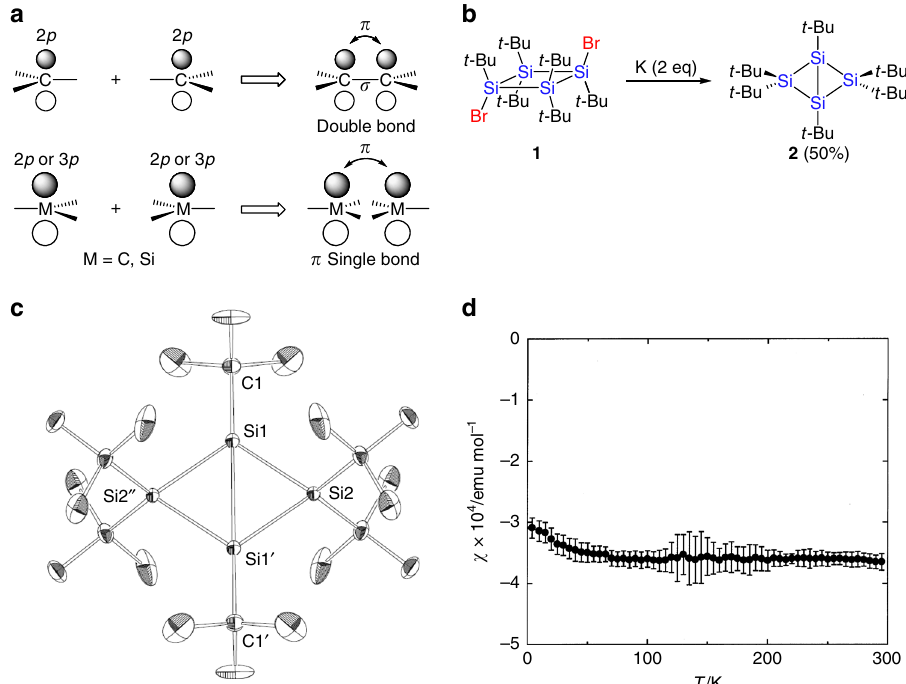
Fig. 1 Synthesis, structure, and magnetic property of 2. a Concepts of a double bond (top) and a π single bond (bottom). b Synthesis of 2 . c Molecular structure of 2 . Thermal ellipsoids are drawn at the 30% probability level. Selected bond length (Å) and angle (°): Si1 – Si2 2.3090(7), Si1 – Si1 ’ 2.853(1), Si1 – C1 1.921(3); Si2 – Si1 – Si1 ’ 51.83(2), Si2 – Si1 – Si2 ” 103.65(4), Si2 – Si1 – C1 128.07(2), Si1 ’– Si1 – C1 176.1(1), Si1 – Si2 – Si1 ’ 76.35(4). d Temperature-dependent magnetic susceptibility of 2 . The data were measured 12 times at each temperature. The black dots denote average values and the error bars show